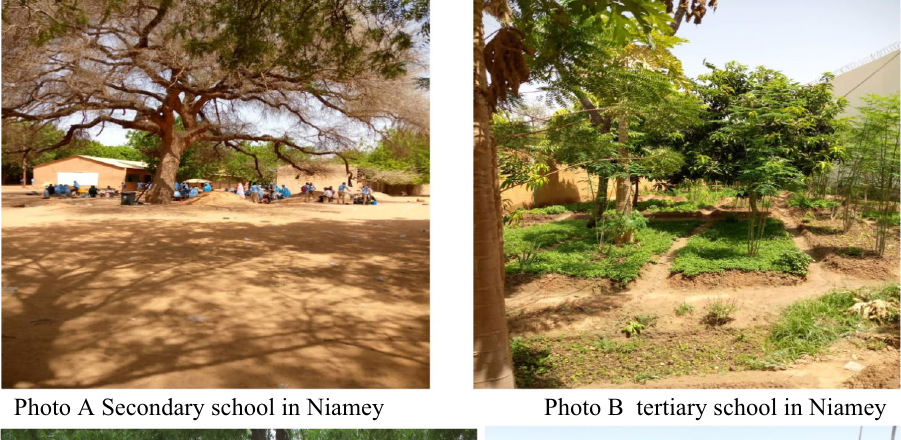
Fig. 1 Tree species diversity in the schoolyards of Maradi